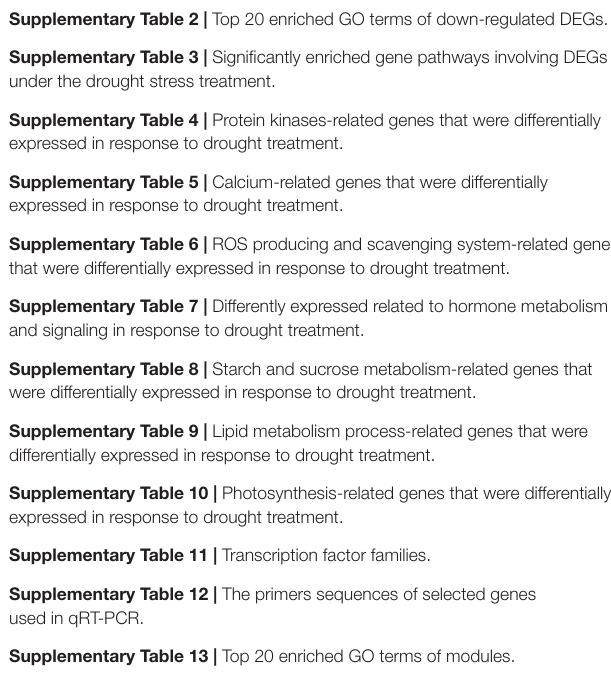
Supplementary Table 13 | Top 20 enriched GO terms of modules. Supplementary Table 14 | Top 20 enriched KEGG pathway of